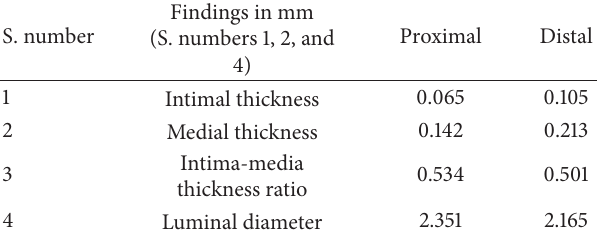
Figure 1: Intraclass Correlation Coefficient (ICC) was 0.91 with mean difference of − 0.001; limit of agreement was 95% with upper and lower limits of − 0.003 and 0.002. 4% values are above the limit of agreement, which means both of these methods are in agreement. Table 3: Postoperative histopathology.